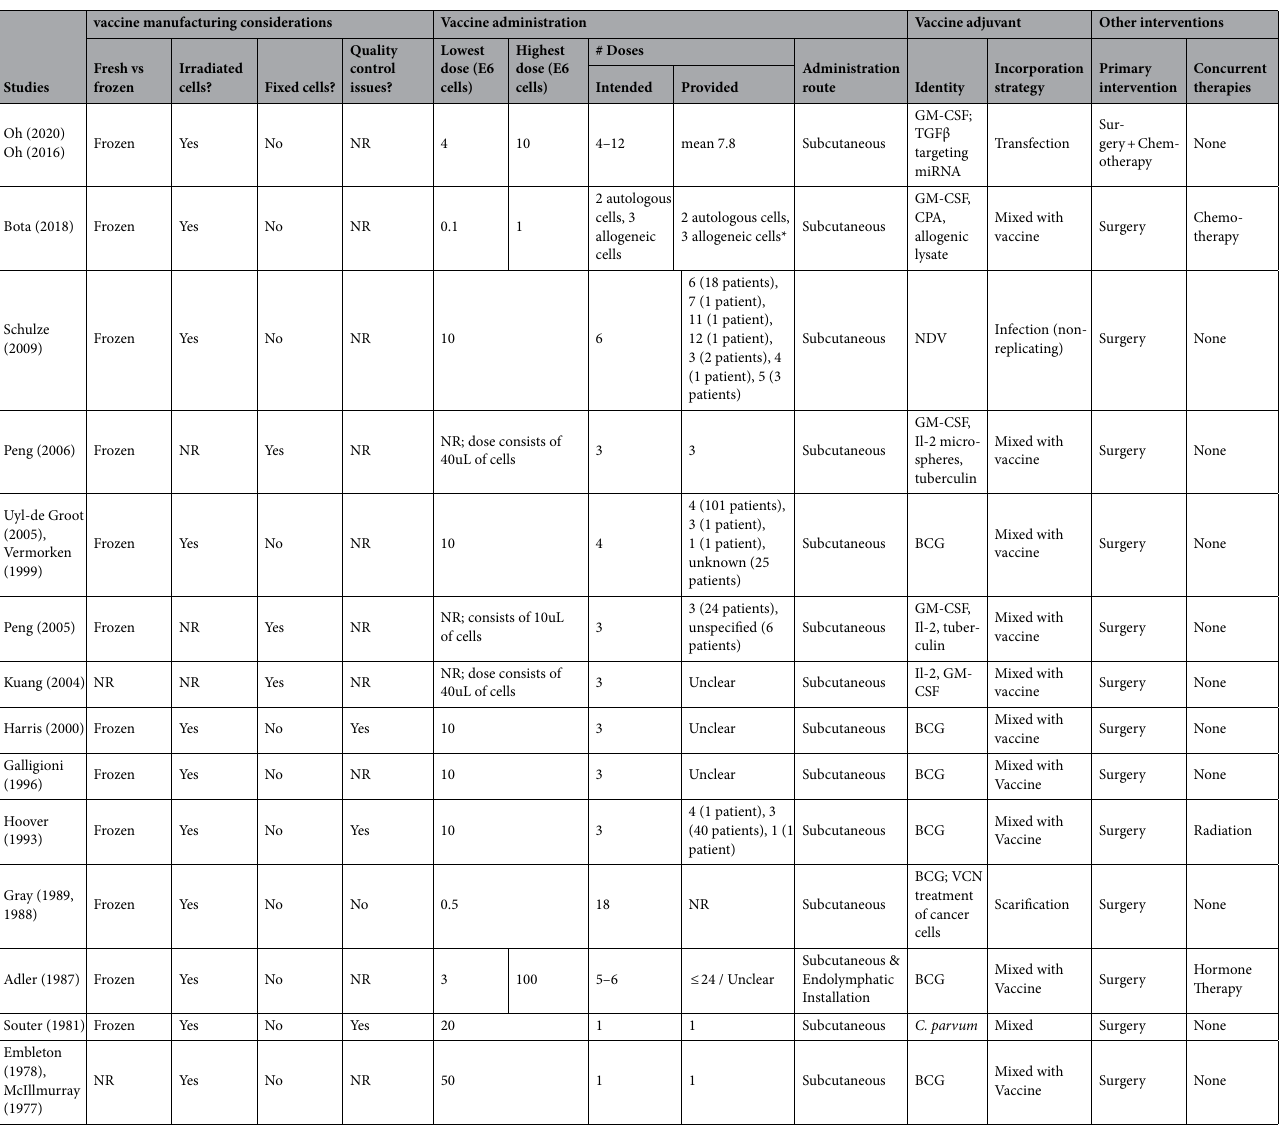
Table 2. Intervention Details. GM-CSF granulocyte macrophage colony stimulating factor, TGFβ tumor growth factor beta, miRNA microRNA, NR none reported, CPA cyclophosphamide, NDV Newcastle